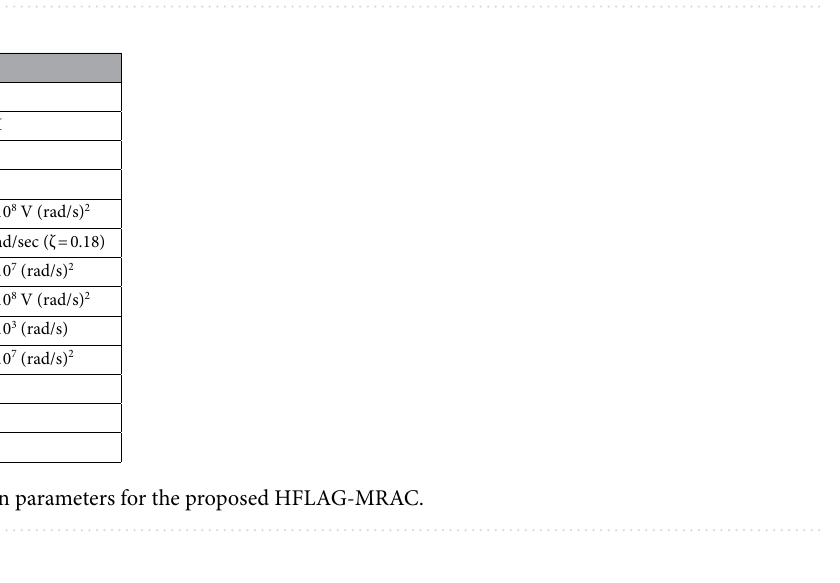
Figure 10. Simulink model of proposed 2-level MPPT control.